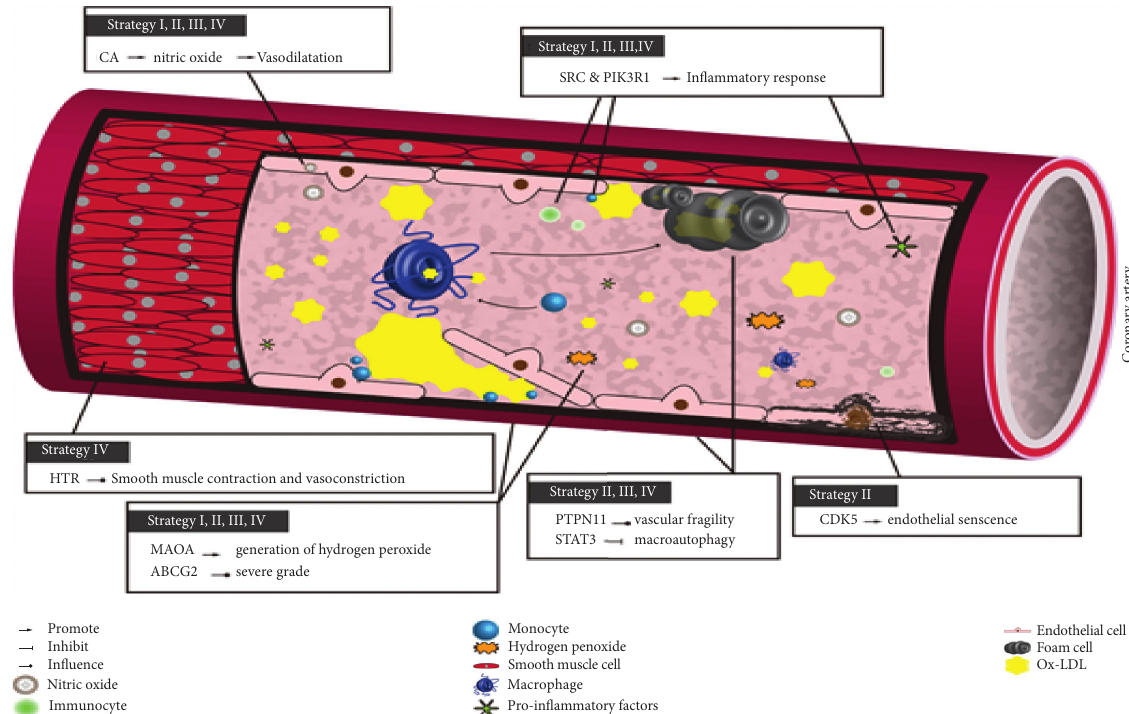
Figure 5: Active molecule targets and bioactions of four herbal strategies against coronary artery